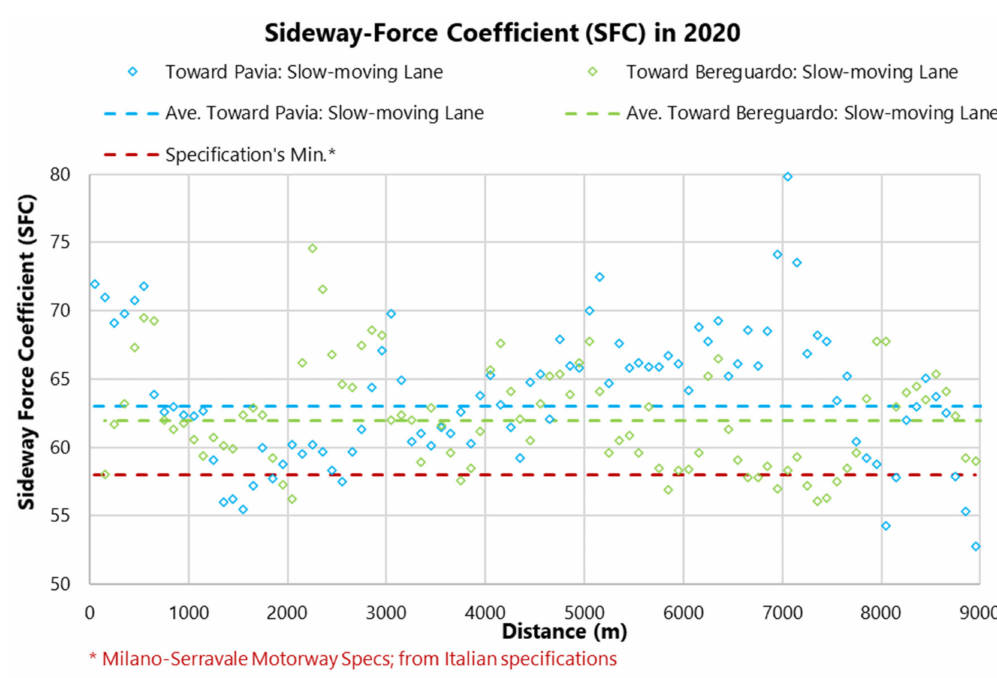
Figure 13. Sideway-force coefficient (SFC) in